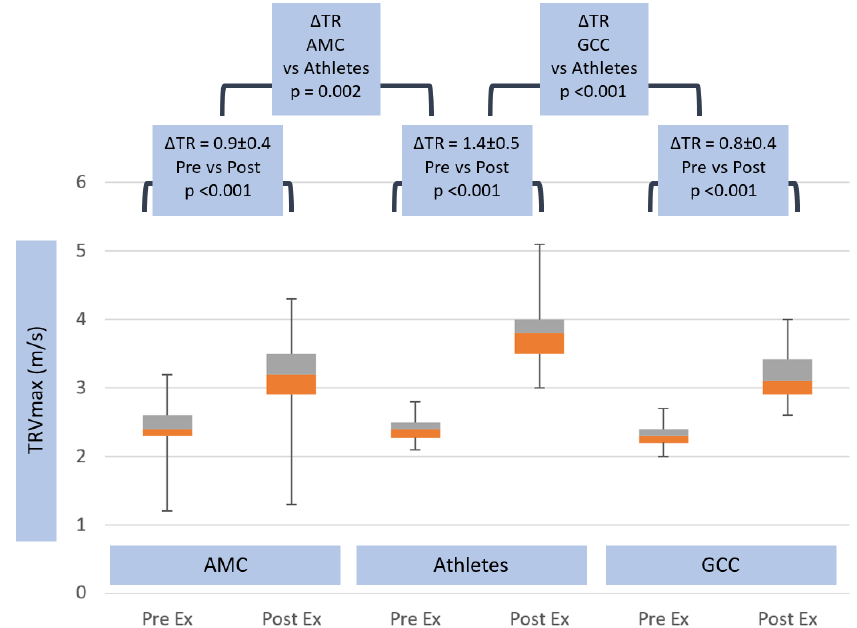
Figure 5. Tricuspid valve TR Vmax response in age matched controls, athletes and general community cohort populations, pre- and post-exercise. The box and whisker plots depict the minimum, first quartile, median, third quartile and maximum values of each data set. The change in TR Vmax from pre- to post-exercise is shown for the three groups, with standard deviations and p -values. The change in TR Vmax between all groups is also shown, with p -value.